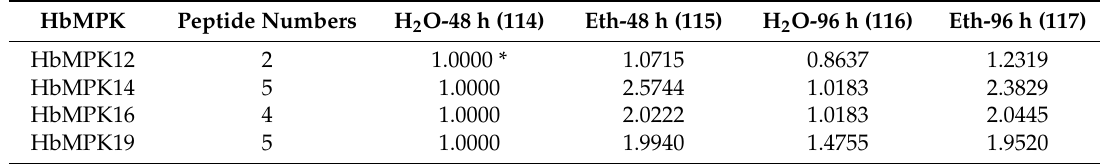
Table 2. Identification and quantitative information of four validated HbMPKs.